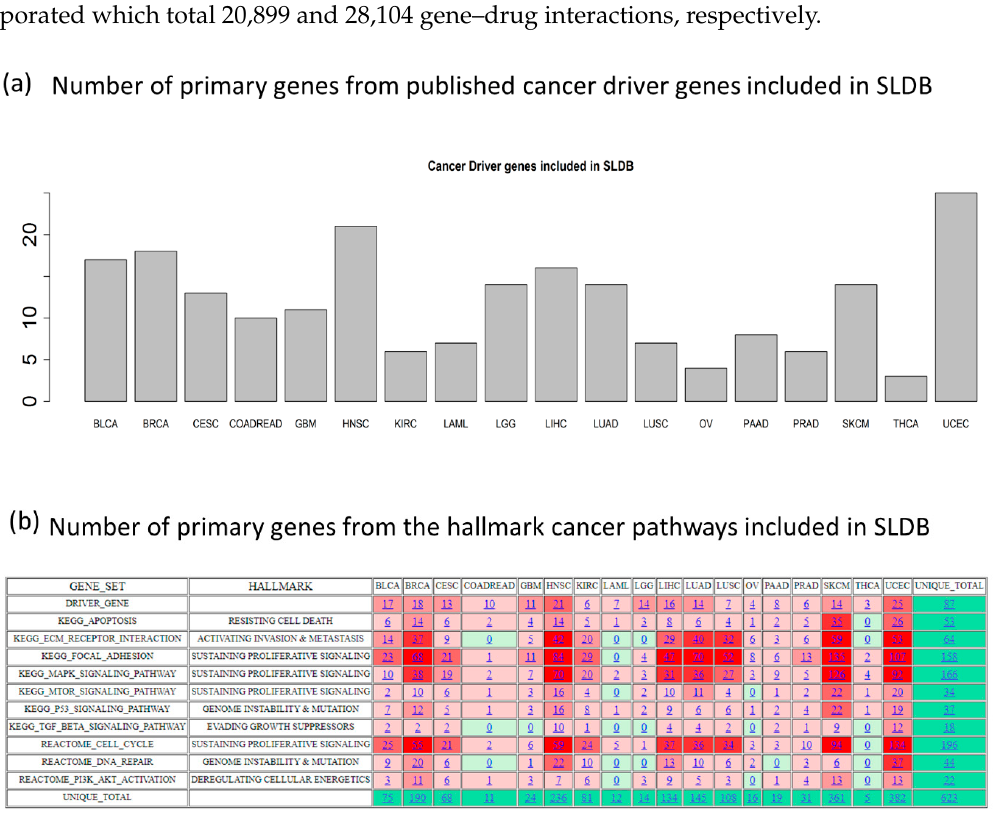
Figure 1. General schema of SL-BioDP: ( a ) The bar-chart shows the number of cancer driver genes in 18 cancer types included as primary genes in SL-BioDP; ( b ) the heatmap shows the number of genes from each of the 10 hallmark cancer pathways included as primary genes in SL-BioDP for each of the 18 cancer types. The color coding is based on the frequency of the number of genes from a pathway in each cancer (red: more number of genes, green: less number of genes). Table 1. The number of SL pairs in each cancer type that passes either of the two validation steps: Conditional sensitivity from RNAi (RNA interference) screening data in cancer cell lines or reported in literature.